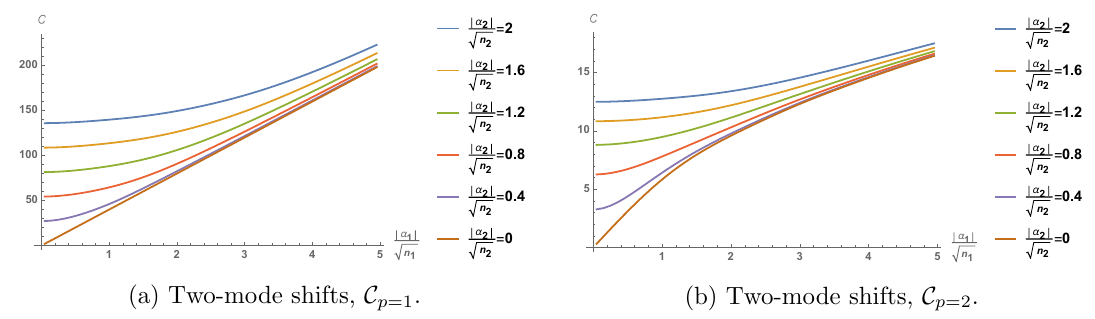
Figure 4. Complexity for two-mode shifts with n N = 200 for the two-mode shift covariance matrice, which is similar to one of the diagonal blocks in